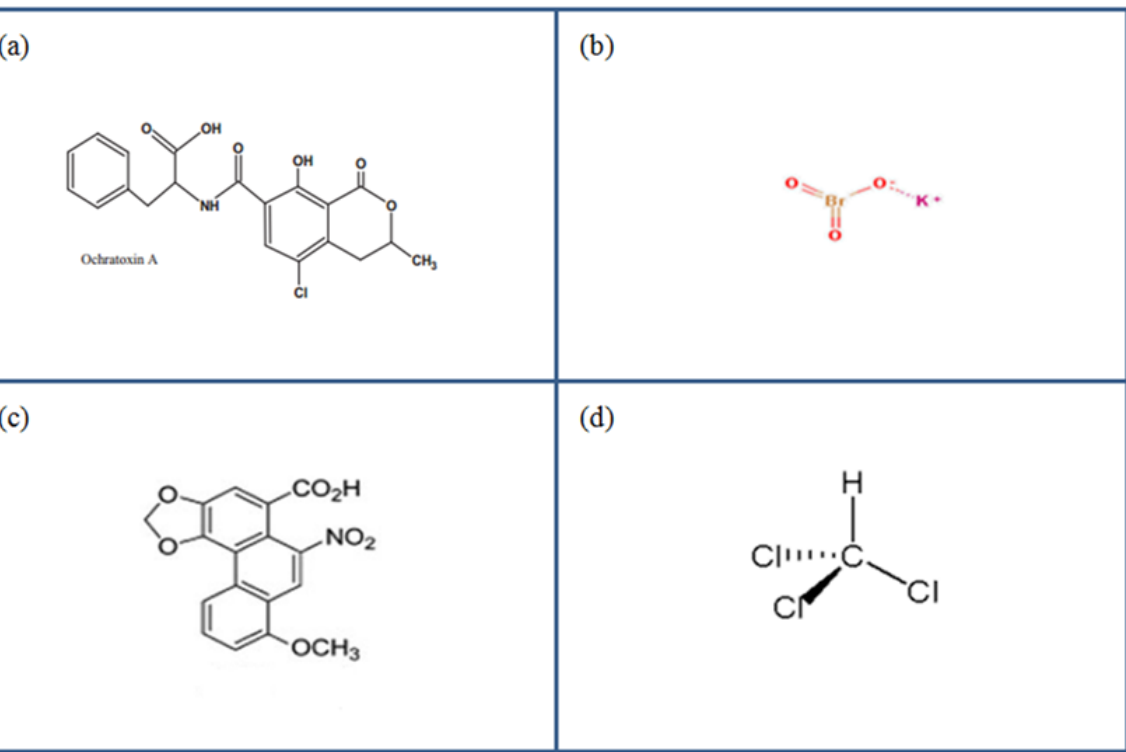
Table 2. Structure of Ochrotoxin A [81] ( a ); Potassium bromated [82] ( b ); Aristolochic Acid [83] ( c ) and Chloroform [84] ( d